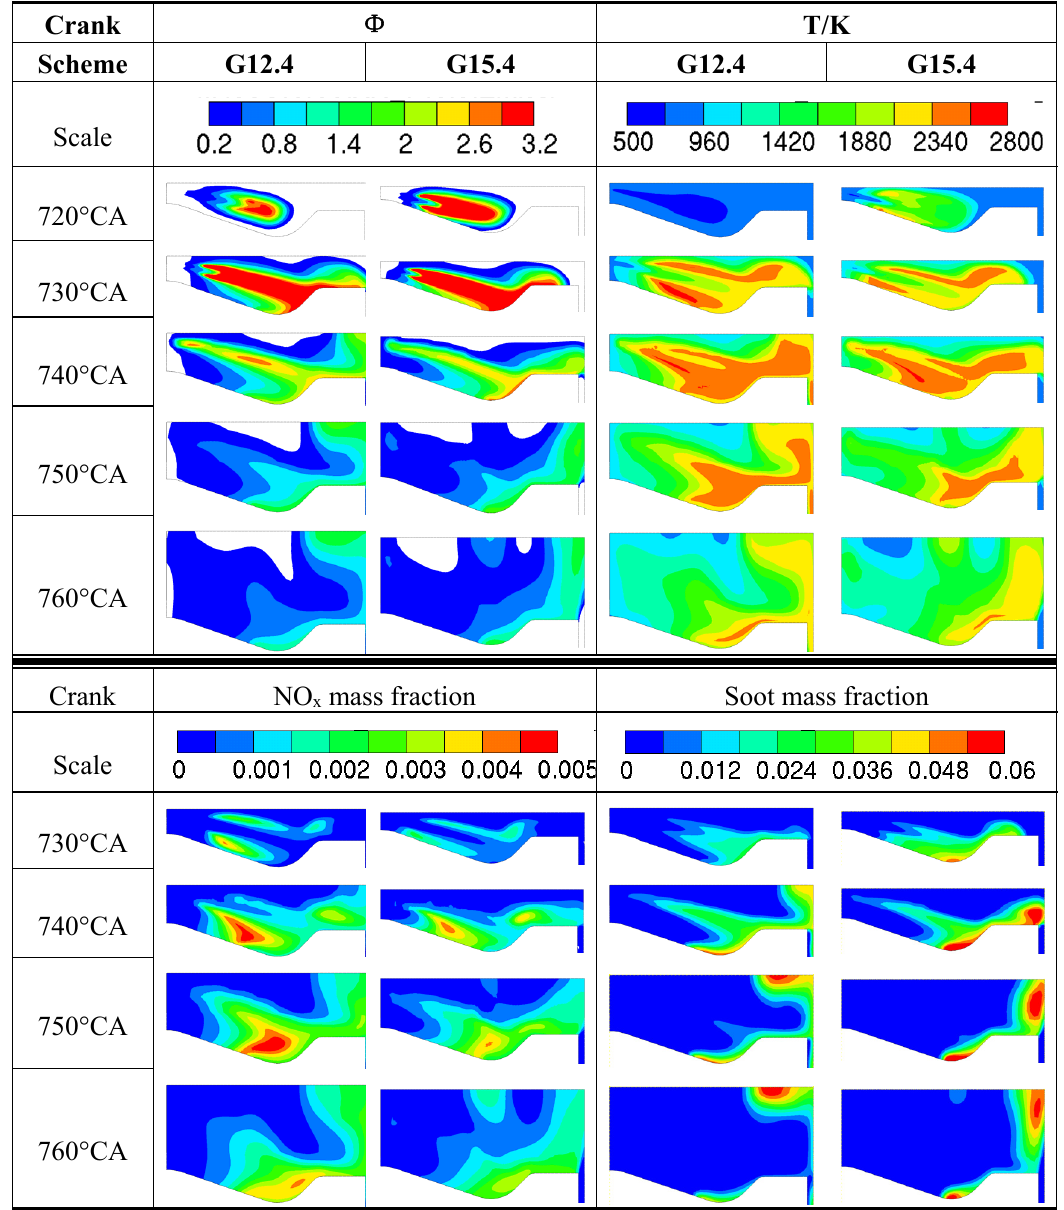
Figure 13. Contour images comparison in Φ , T, NO x , and soot mass fraction between G12.4 and G15.4.